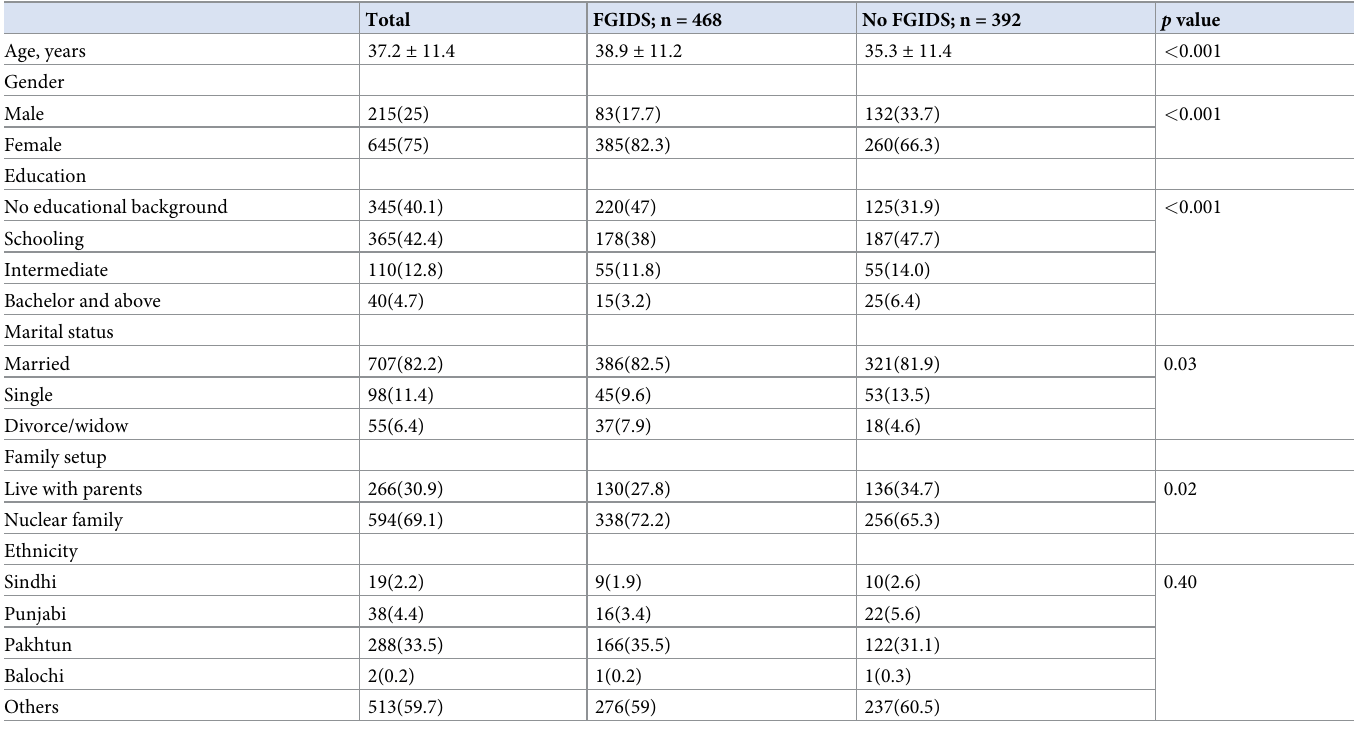
Table 1. Characteristics of study population (n =